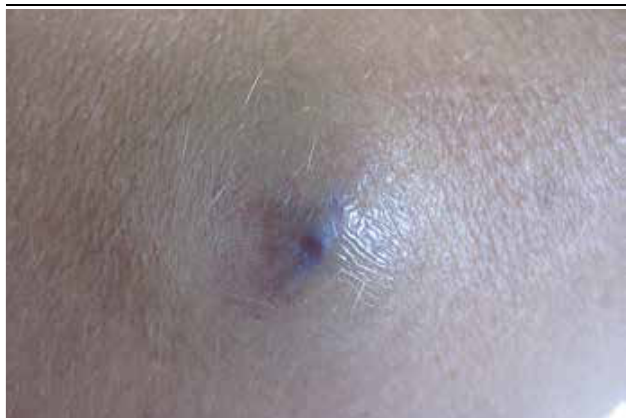
figuRE 2 − Detail of the nodular lesion